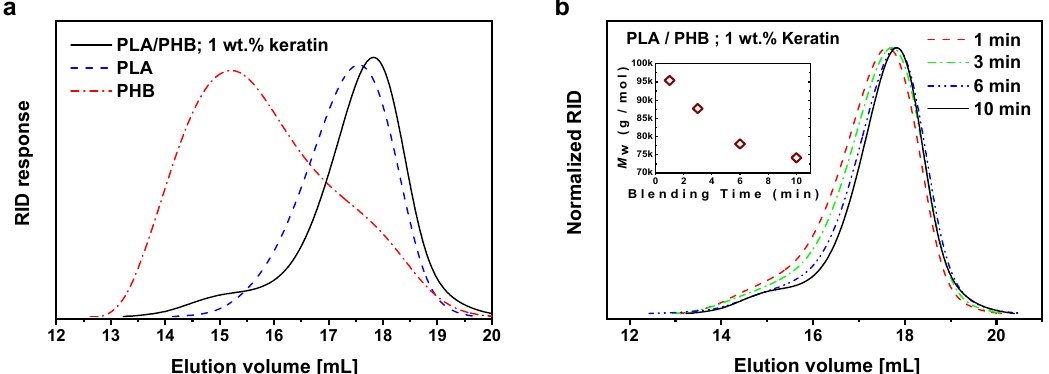
Figure 9. ( a ) GPC traces of original PLA, original PHB and prepared PLA / PHB composite filled with 1 wt % of keratin and ( b ) evolution of GPC traces during melt blending of PLA / PHB composite filled with 1 wt % of keratin at 175 ◦ C; samples were taken after 1, 3, 6 and 10 min of blending. Inset shows evolution of M w during the melt blending. Table 1. Mass weight molar masses of PLA / PHB blend and all prepared keratin composites. Polymer